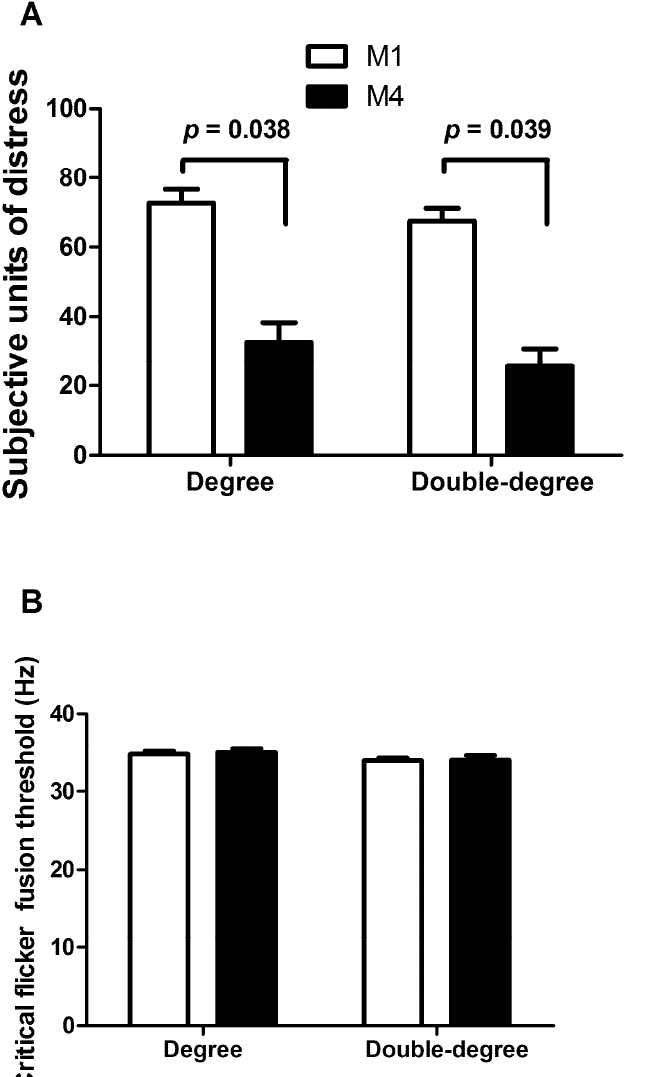
Figure 2. ( A ) Subjective units of distress and ( B ) critical flicker-fusion threshold (mean ± SD) before (M1) and after (M4) the bachelor’s thesis defense of degree or double-degree